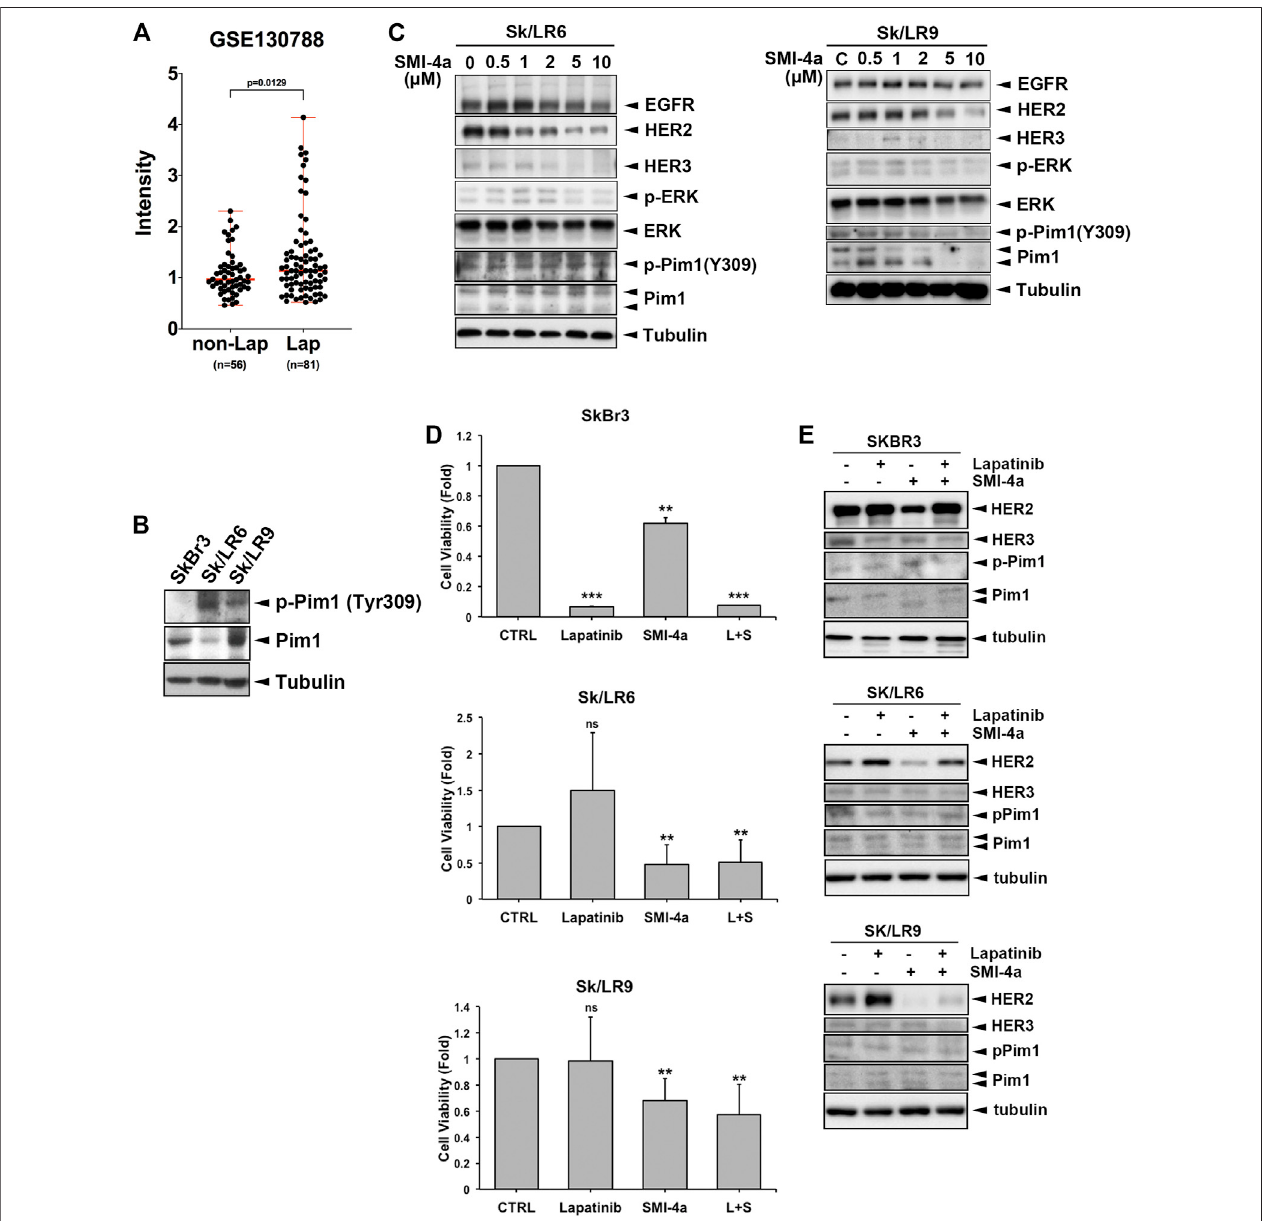
FIGURE 7 | Pim1 inhibitor suppressed HER family expression and cell viability in lapatinib-resistant breast cancer cells. (A) The level of Pim1 mRNA in HER2- positive breast cancer patients who were treated with or without lapatinib in GEO database (GSE130788). (B) Total lysates of SkBr3 and its derived lapatinib-resistant Sk/LR6andSk/LR9cellswereharvested.Proteinexpressionswereexaminedbywesternblotusingindicatedantibodies. (C) Sk/LR6andSk/LR9cellsweretreatedwith SMI-4a at 0, 0.5, 1, 2, 5, 10 μ M and whole-cell lysates were harvested. Protein expressions were examined by western blot using indicated antibodies. (D) SkBr3, Sk/LR6andSk/LR9cellsweretreatedwithlapatinib(1 μ M),SMI-4a(10 μ M),thecombinationoflapatinibandSMI-4a,respectivelyfor3days.Cellviabilitywasexamined byMTTassay.L+S:thecombinationoflapatinibandSMI-4a.Resultswereexpressedasmean ± S.E.M.ofthreeindependentexperiments.**: p < 0.01;***: p < 0.001as compared with control group. (E) SkBr3, Sk/LR6, and Sk/LR9 cells were treated with lapatinib (1 μ M), SMI-4a (10 μ M), the combination of lapatinib and SMI-4a, respectively for 3 days and whole-cell lysates were harvested. Protein expressions were examined by western blot using indicated antibodies.